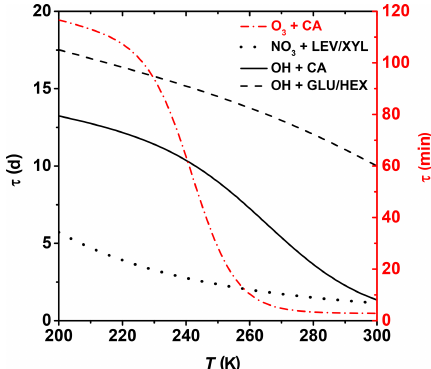
Figure 10. Lifetime estimates of one monolayer of examined OA surrogates for typical background concentrations of O 3 , NO 3 , and OH. See text for more